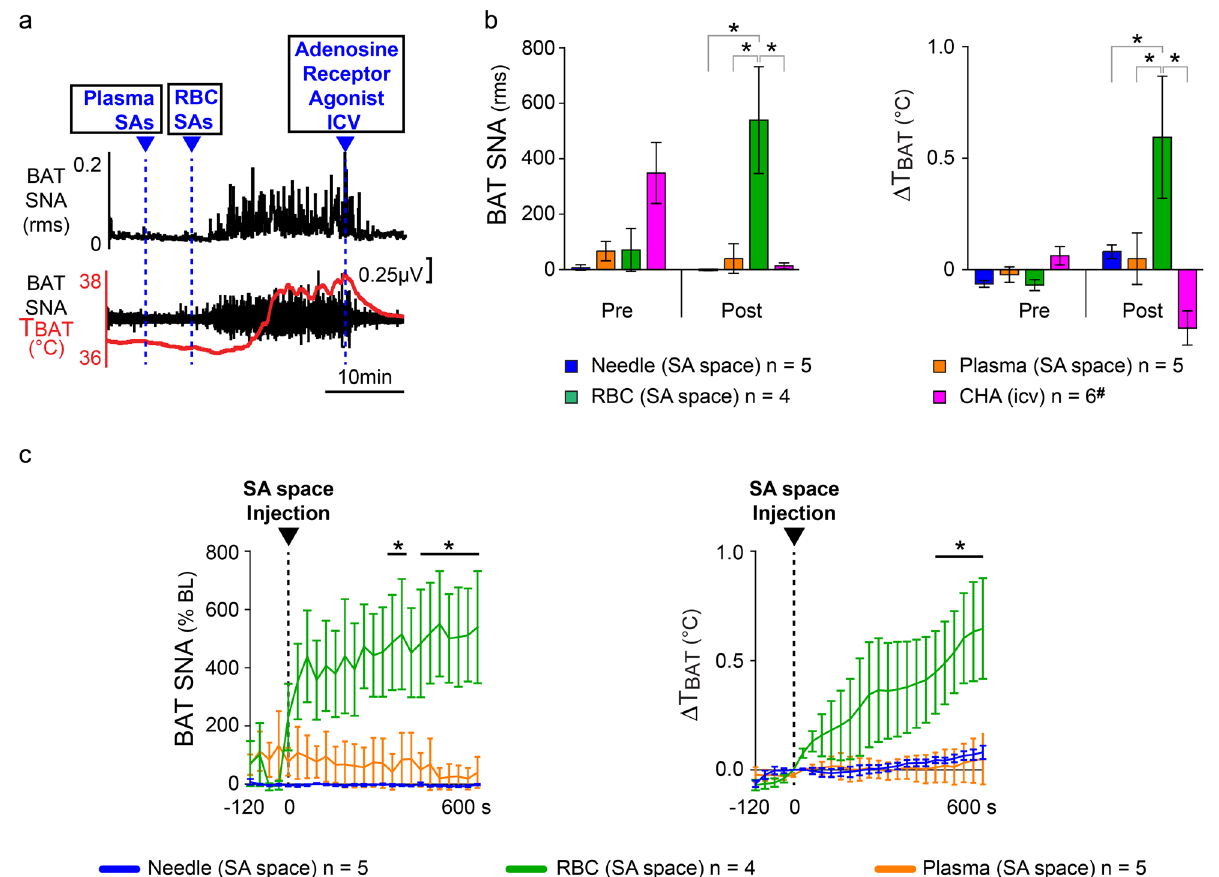
Figure 3. Injection of the red blood cell (RBC) fraction, but not plasma, into the SA space activates BAT SNA and BAT thermogenesis, contributing to NF. ( a ) An example of the effects on BAT SNA and T BAT of injection of plasma or of red blood cells in the SA space (SAs). The injection of red blood cells, but not plasma, into the SAs elicited a prompt increase in BAT SNA and BAT thermogenesis (increase in T BAT ). # The increases in BAT SNA and BAT thermogenesis elicited by either injection of red blood cells (n = 3) or blood (n = 3) in the SAs were blocked by the intracerebroventricular (icv) injection of the A1 adenosine receptor agonist, CHA (n tot = 6). ( b ) Group data showing the effect on BAT SNA and BAT thermogenesis resulting from insertion of the needle into the SA space (blue bars); injection of plasma into the SA space (orange bars); injection of RBC into the SA space (green bars); or injection of CHA icv (pink bars). ( c ) Time course of the effects on BAT SNA and T BAT following the insertion of the needle, or the injection of plasma or of RBC into the SA space. *p < RBC rather than plasma produces NF.